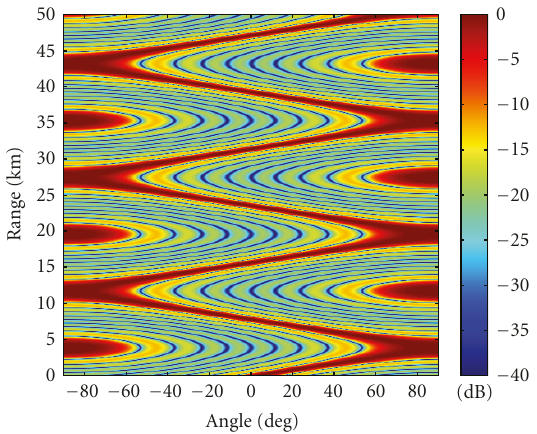
Figure 3: The beam direction varies as a function of frequency o ff set.